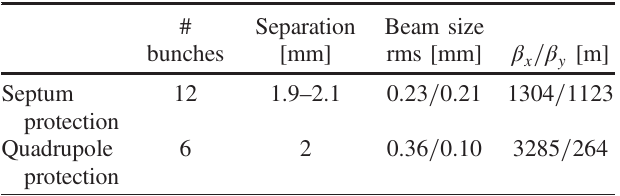
TABLE IV. Beam parameters on the protection absorbers in the alternative